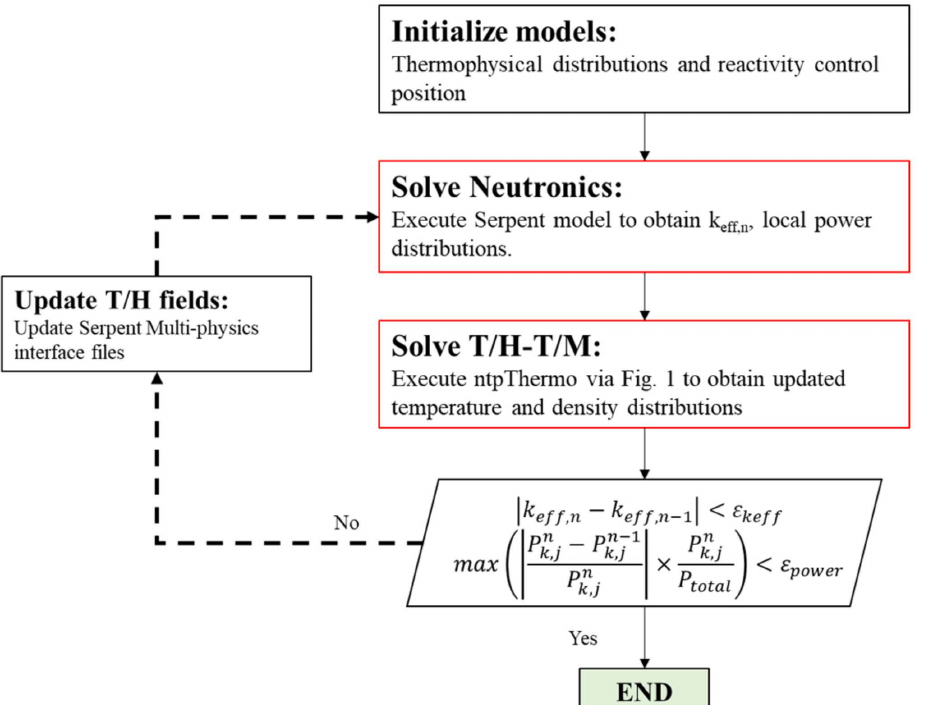
Figure 2. Coupled N+T/H–T/M solution sequence.